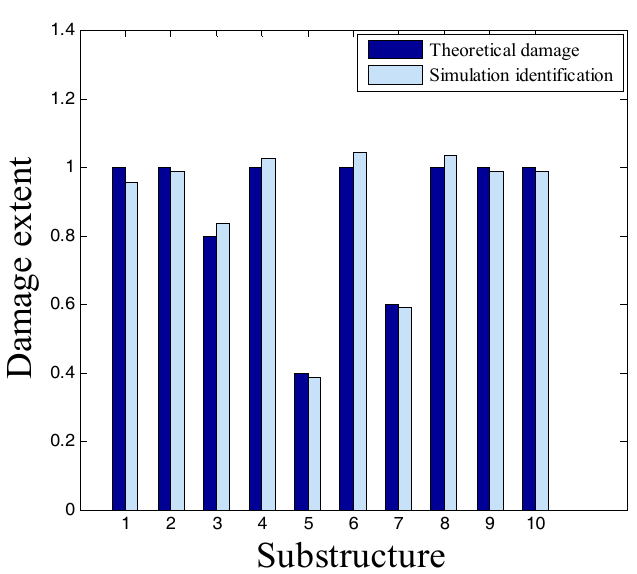
Appl. Sci. 2017 , 7 , 1040